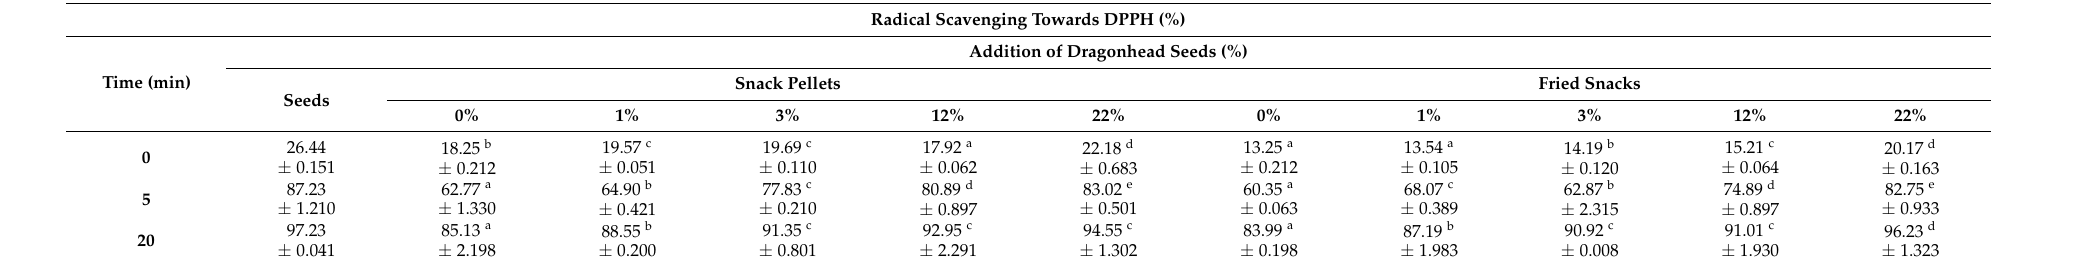
Table 3. Radical scavenging activity (%) of snack samples depends on time and dragonhead seed addition ( n = 3 mean ± SD). Radical Scavenging Towards DPPH